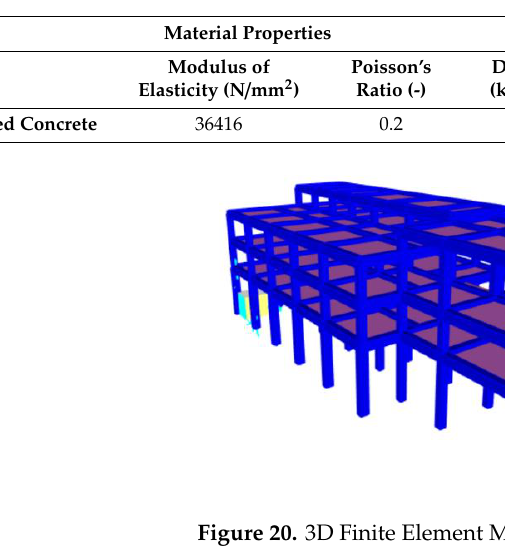
Table 5. Material properties and elements type adopted in the FE models—Structure B.